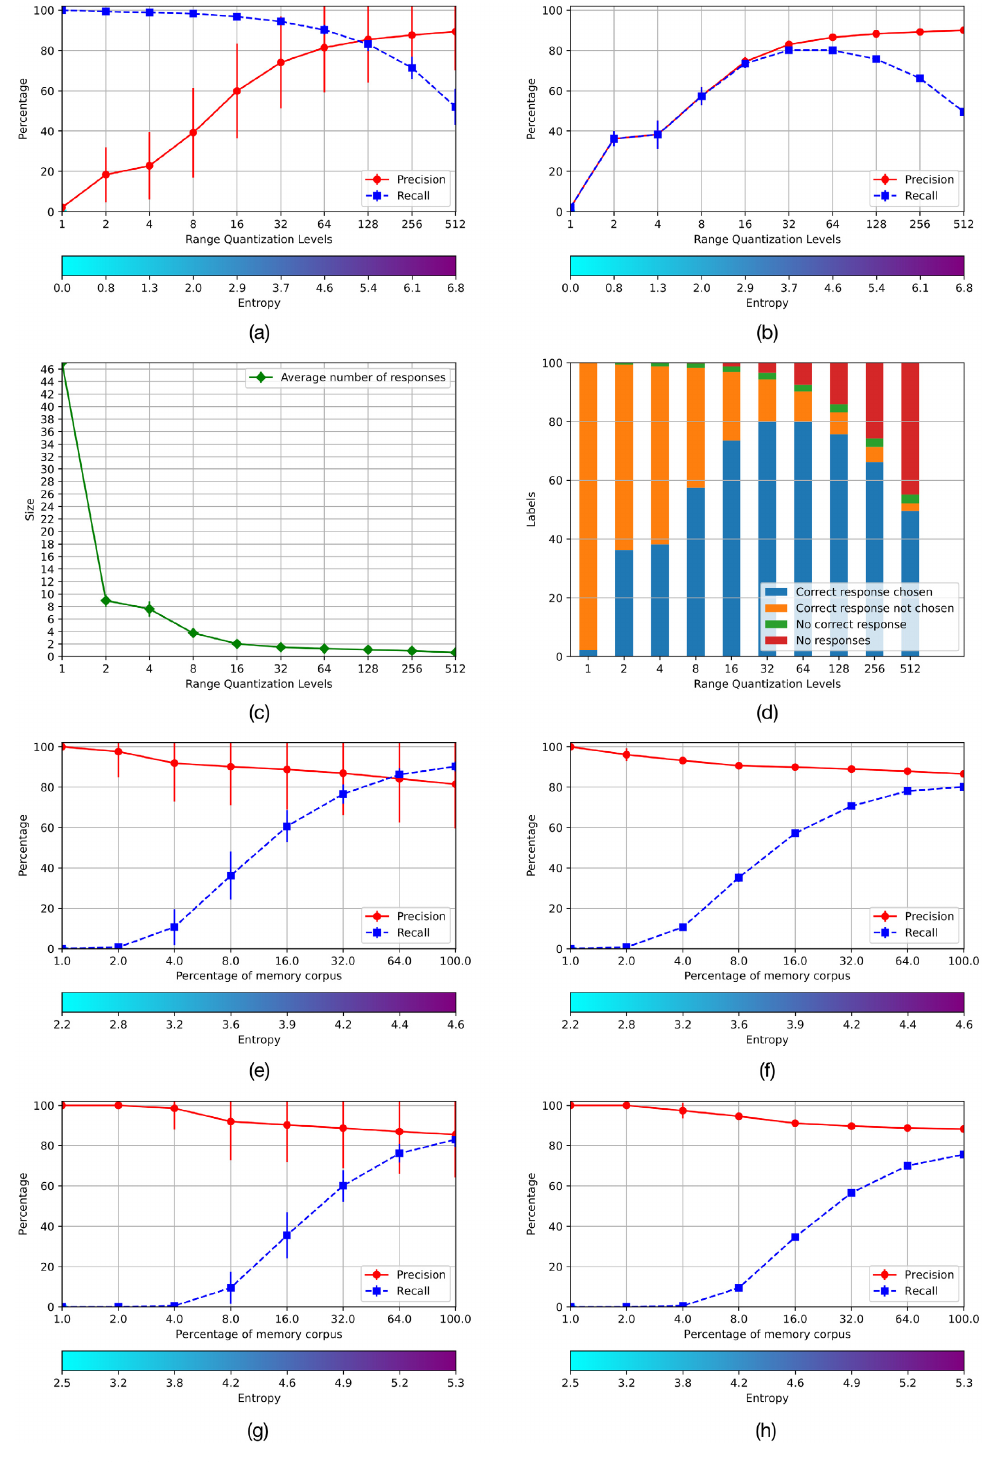
Fig 7. Results of Experiment 1 using